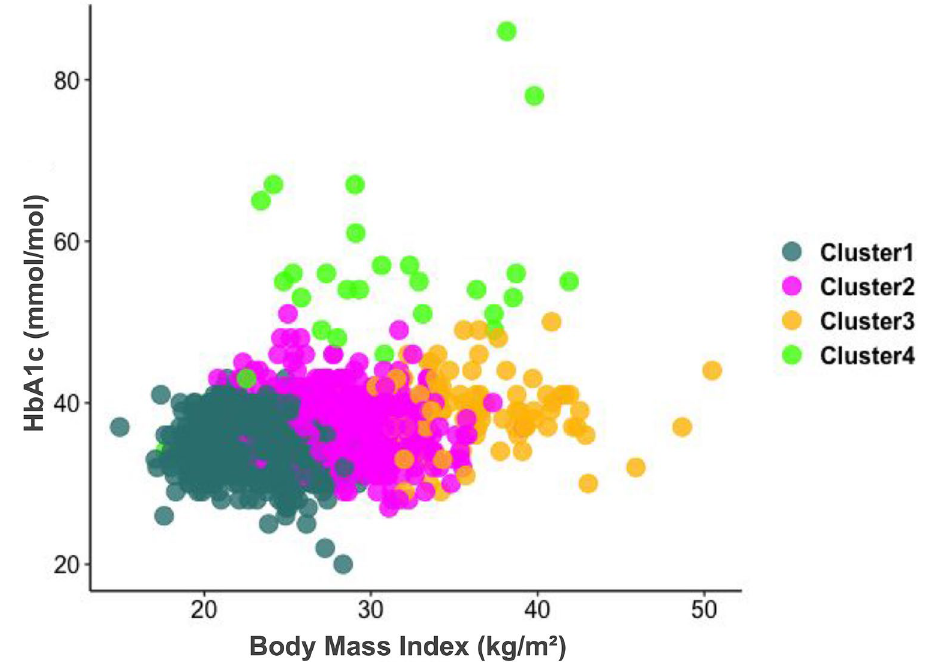
Figure 2. Scatter plot of body mass index and HbA1c distribution (ORISCAV-LUX 2 study, N =